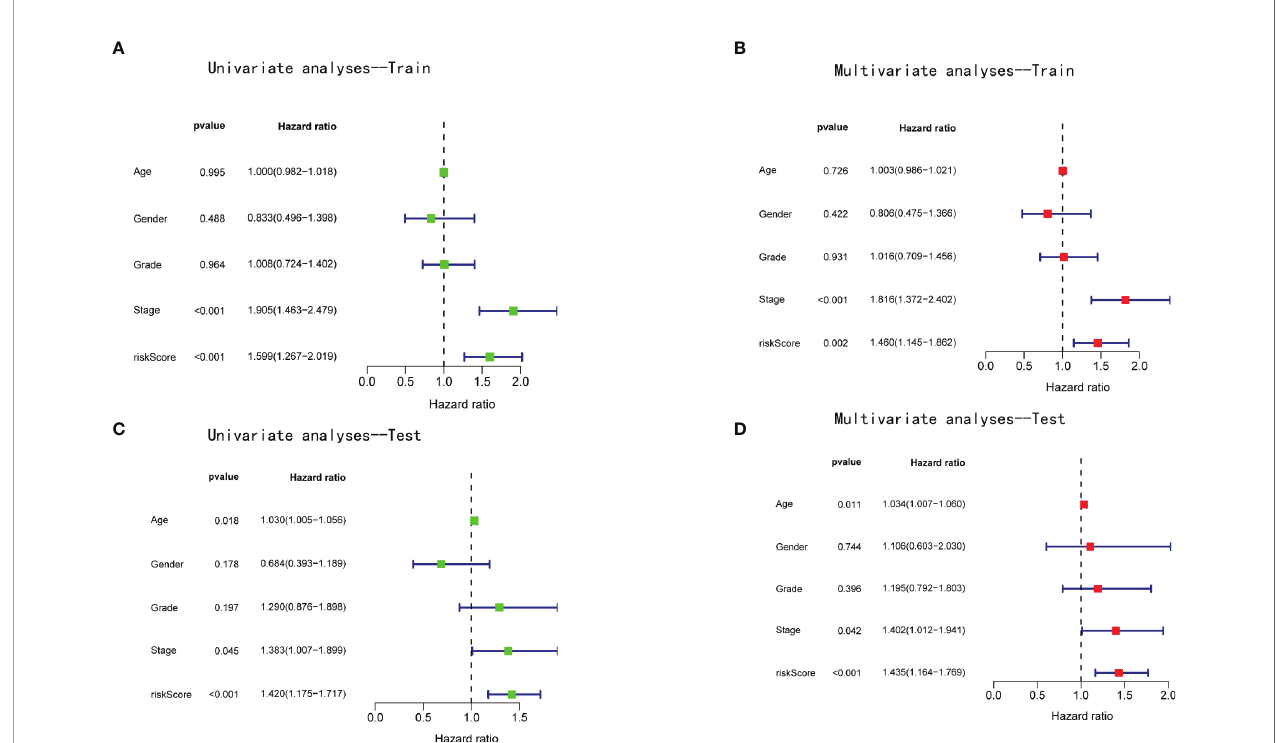
FIGURE 4 | The risk score of the model was an independent prognostic factor for patients with LIHC. Univariate Cox regression analyses in the (A) training and (B) validation cohorts. Multivariate Cox regression analyses in the (C) training and (D) validation cohorts.